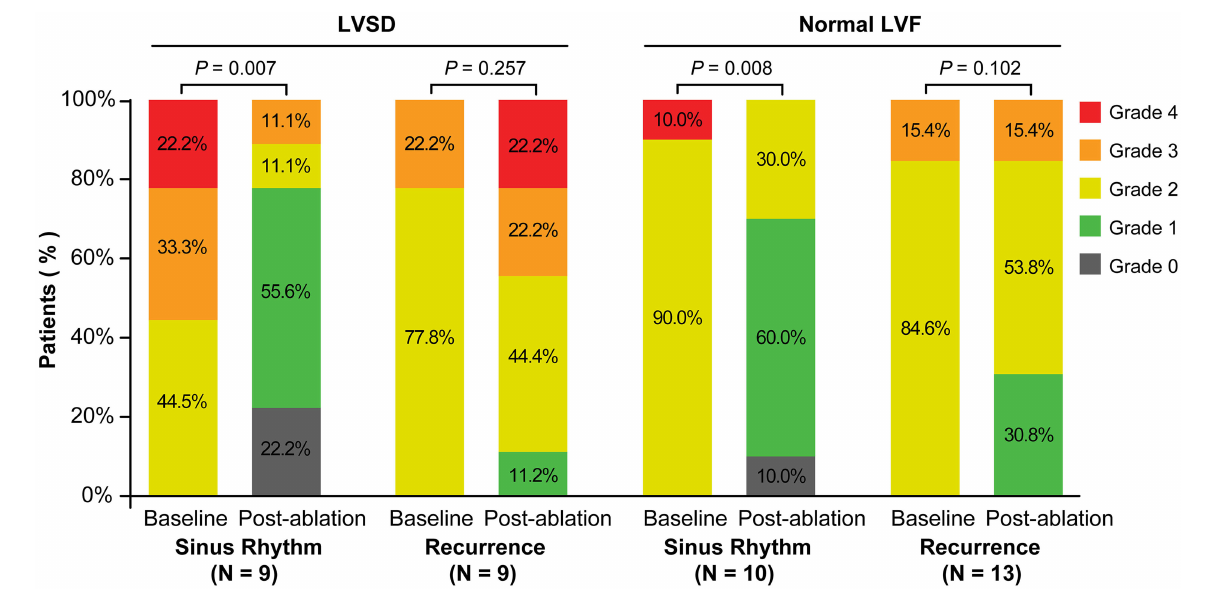
Frontiers in Cardiovascular Medicine |